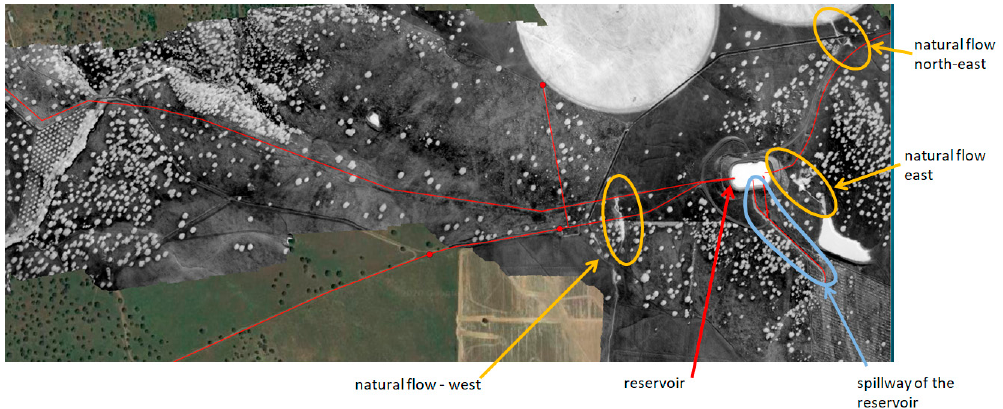
Figure 19. WI image obtained with the MAV on 11 September 2019, in the Vale do Gaio district, Portugal, with the Barras water reservoir. The spillway of the reservoir can be seen in the southeast, together with three “water anomalies” which, after ground inspection, were actually explained as natural water flows. Other WI positive signatures originate from trees (scattered small circles) and two irrigated fields (large white disks in the northeast of the image).